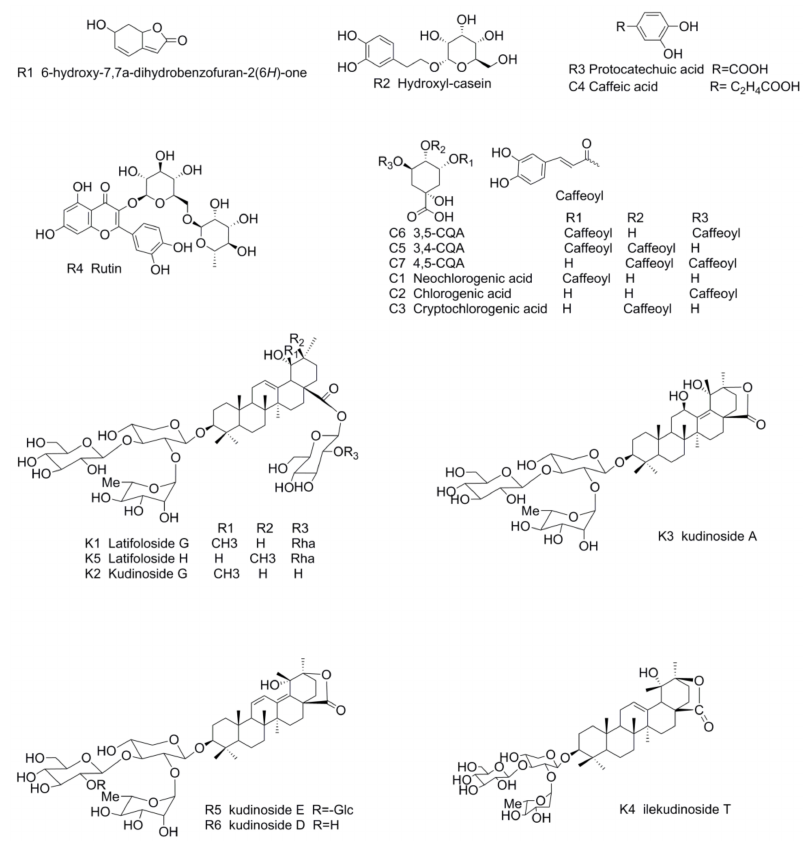
Figure 7. Chemical structures of the 18 target compounds.